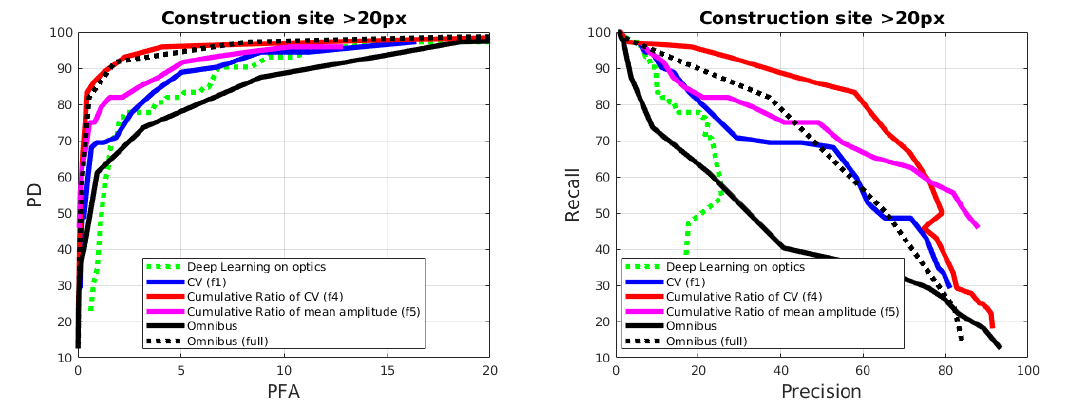
case of construction site detection of size > 20 px (Saclay site, France) PD/PFA